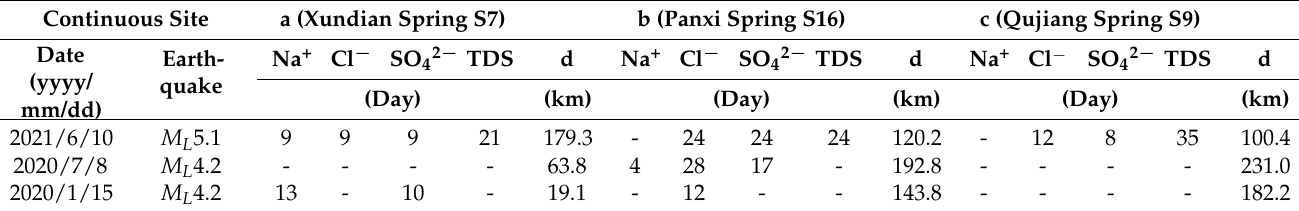
Table 2. Analytical data of reservoir temperature and circulation